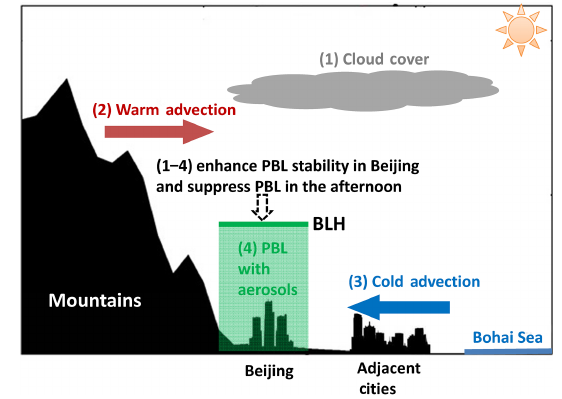
Figure 12. Schematic diagram of factors/processes suppressing the PBL over Beijing in the afternoon, including (1) high cloud cover, (2) westerly warm advection above the PBL, (3) southerly cold ad- vection within the PBL, and (4) aerosols within the